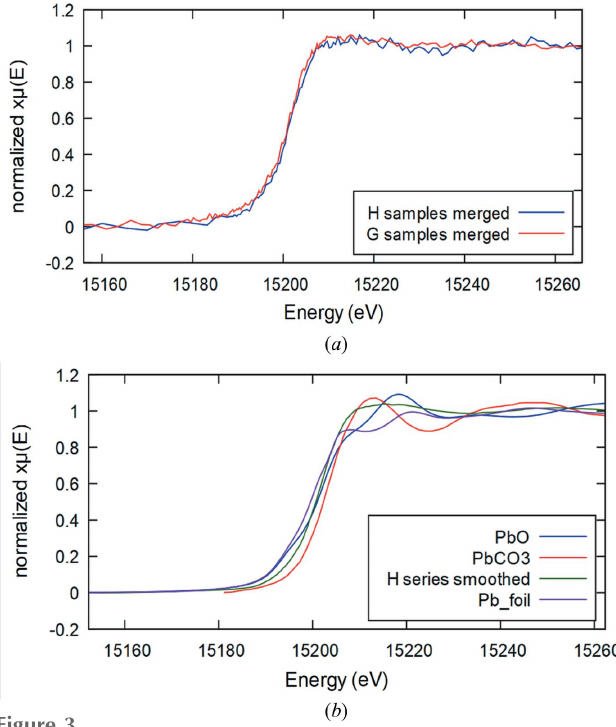
Figure 3 ( a ) Comparison between the Pb L 2 -edge normalized spectra representa- tive of the H and G sample series. ( b ) Reference spectra of Pb-bearing compounds [Pb metal foil, PbO and PbCO 3 taken from Lanzirotti et al. (2014)] compared with the representative spectrum of the H series (with soft smoothing for better visualization).